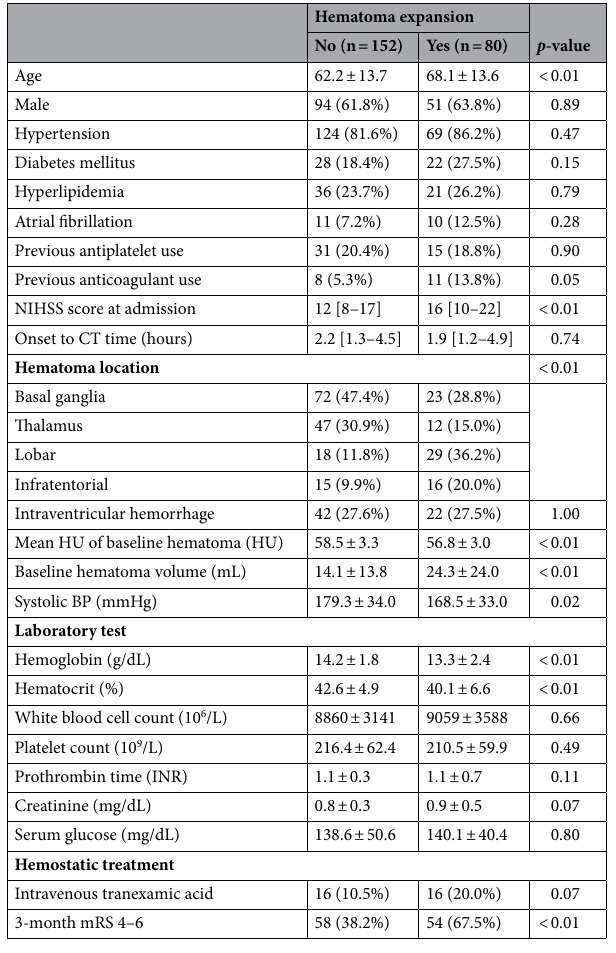
Table 1. Characteristics according to hematoma expansion. NIHSS, National Institute of Health Stroke Scale; LNT, last known normal time; CT, computed tomography; HU, Hounsfield unit; BP, blood pressure; INR, international normalized ratio; mRS, modified Rankin Scale.